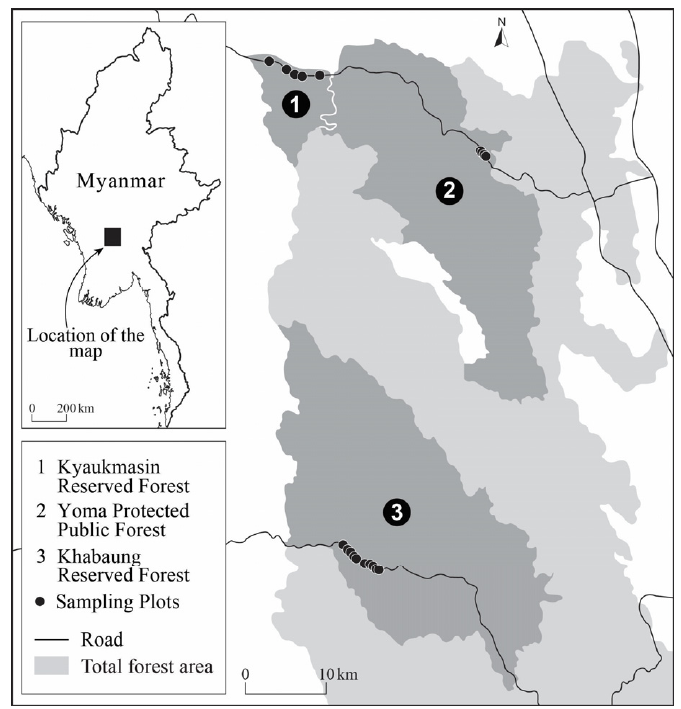
Figure 1. Study sites in the Bago Yo Ma Mountain Range, Taungoo District, Myanmar.